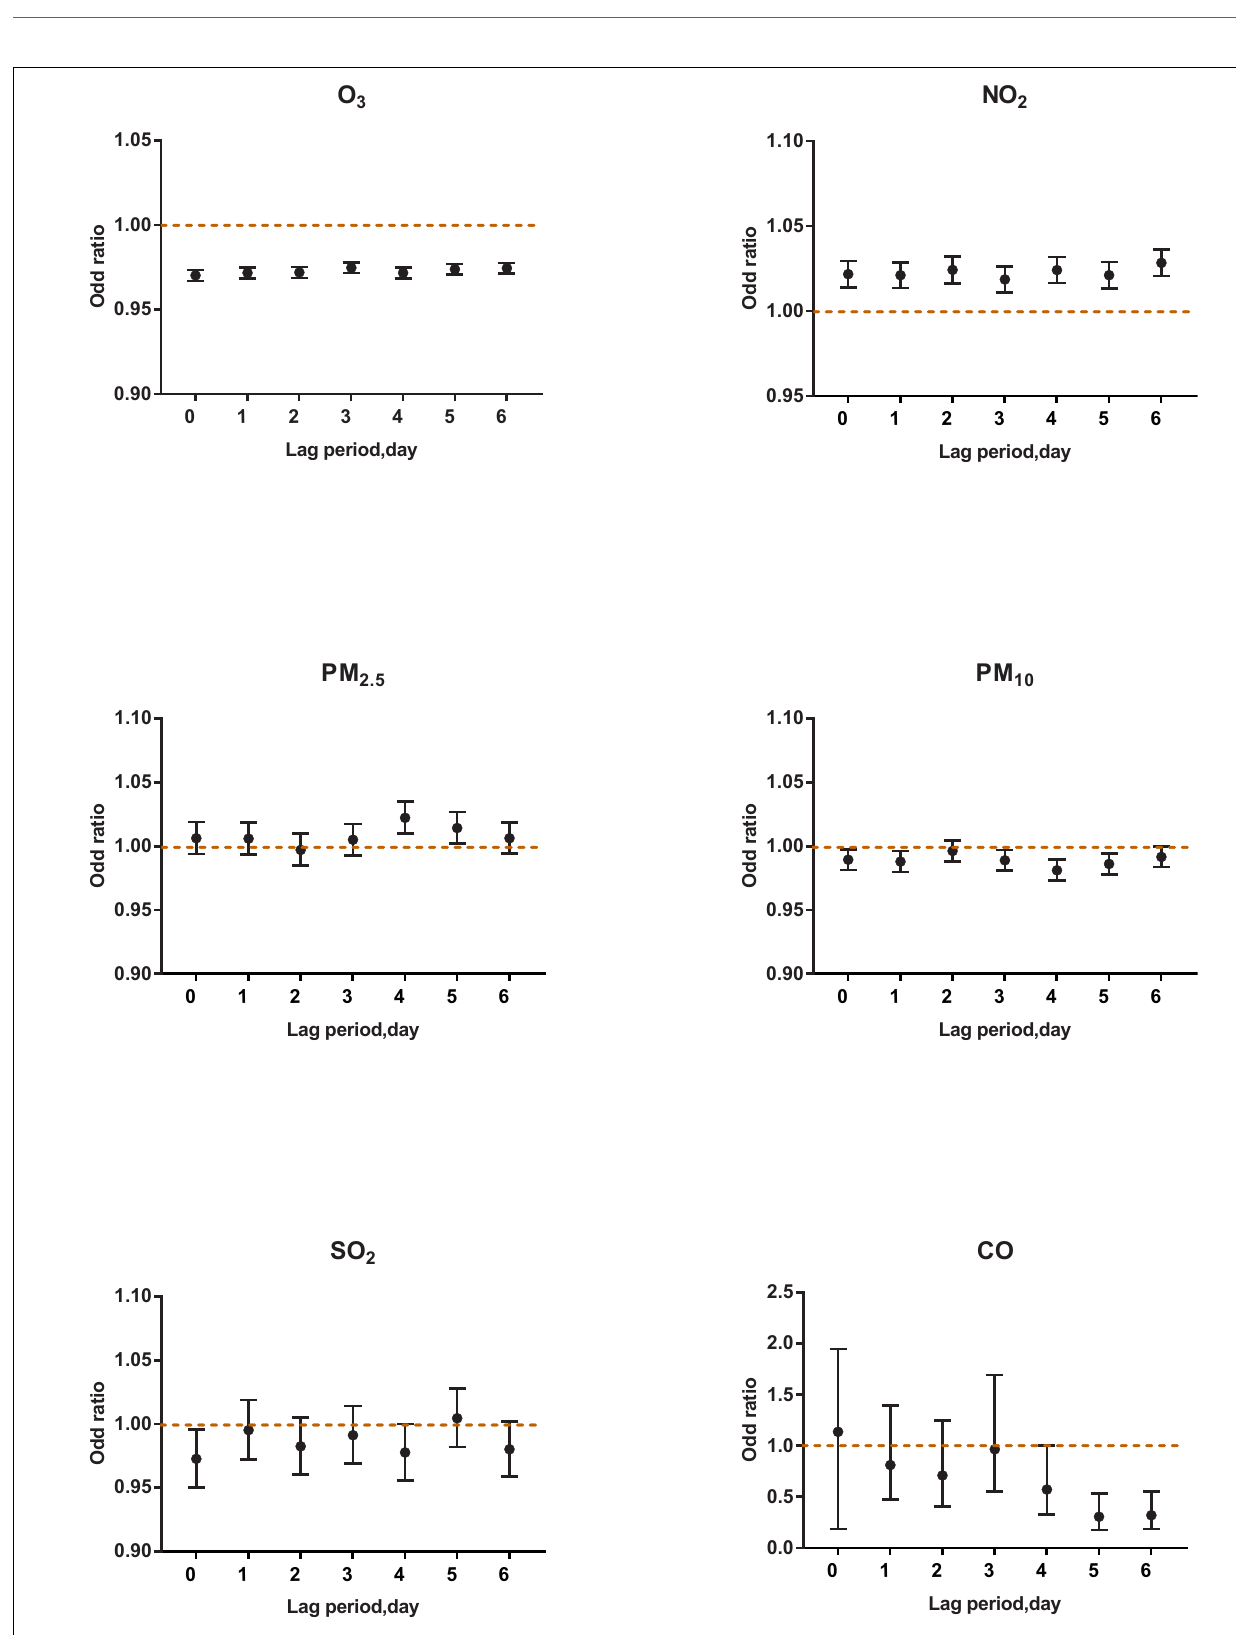
FIGURE 6 | Air pollutants in different lag periods in the multi-pollutant model when O 3 -8 h was less than 80 µ g/m 3 .